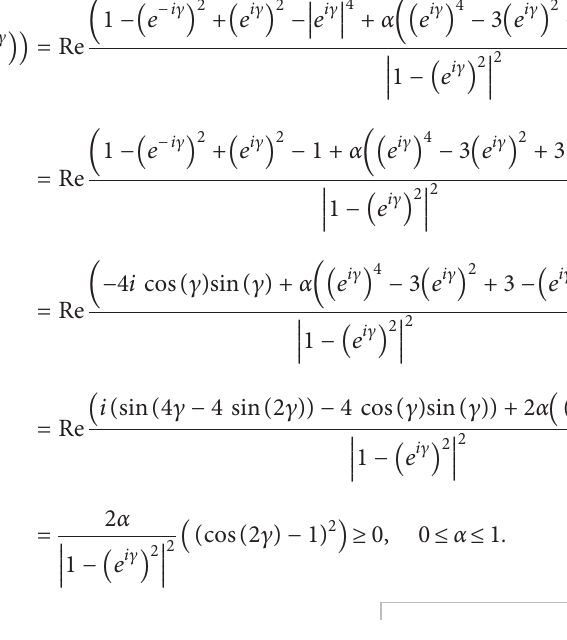
imaginary axis. Figure 8 gives an illustration of images of U under K for several values of α α